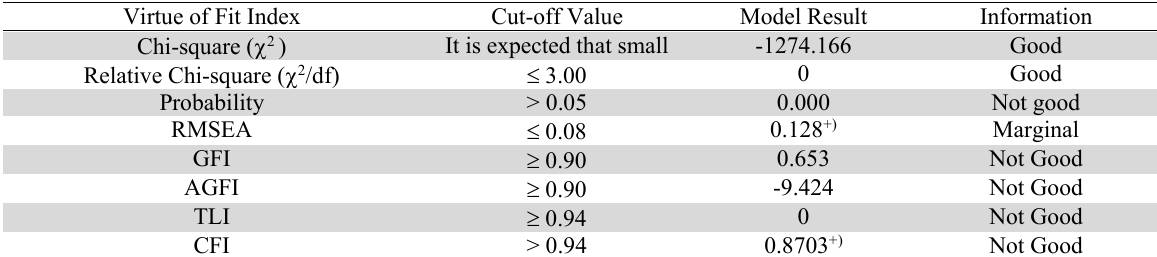
Goodness of Fit Evaluation